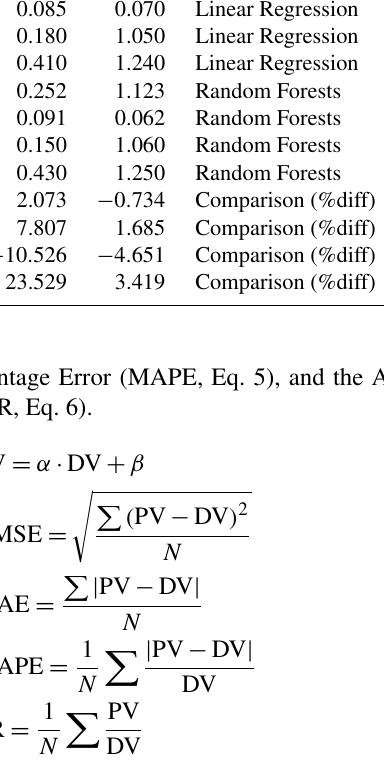
Table 1. Accuracy metrics and comparison. Metric α RMSE MAE MAPE SR Method